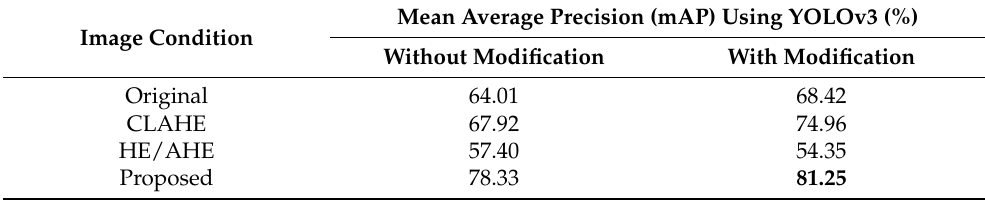
Table 2. mAP performance for mass detection before and after YOLOv3 modification using different image enhancement